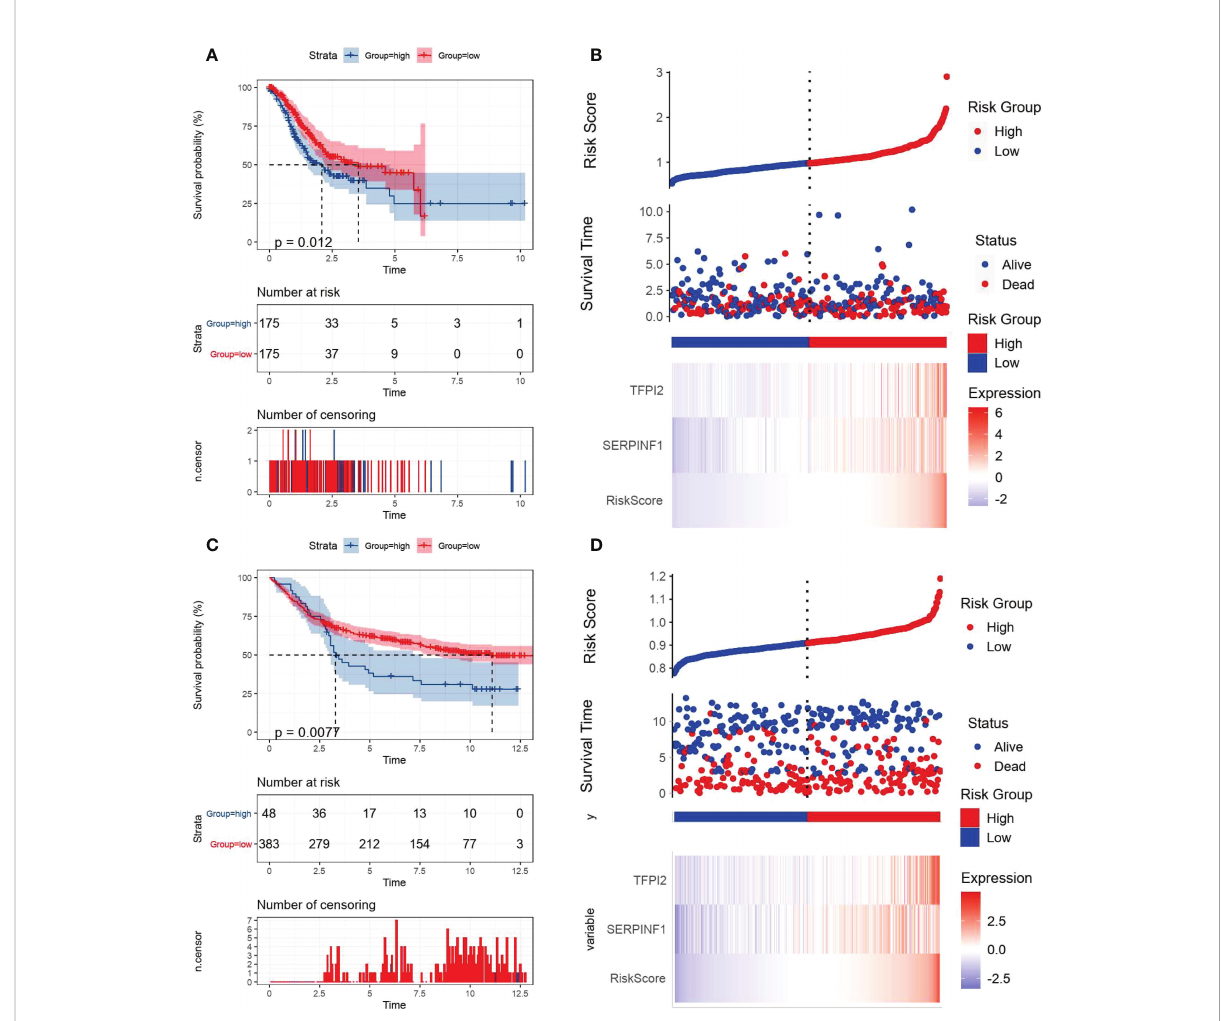
FIGURE 3 Kaplan-Meier plots and risk assessment model for prognosis prediction in the TCGA and GEO databases. All GC cases were strati fi ed in to high- and low-VM index groups based on median risk score in (A, B) the TCGA training cohort and (B, C) the GEO testing cohort. (A, C) Kaplan-Meier curves revealed that individuals with high risk displayed diminished survival probability than those with low VM index. (B, D) Risk survival status plots were consistent with the heatmaps for genes